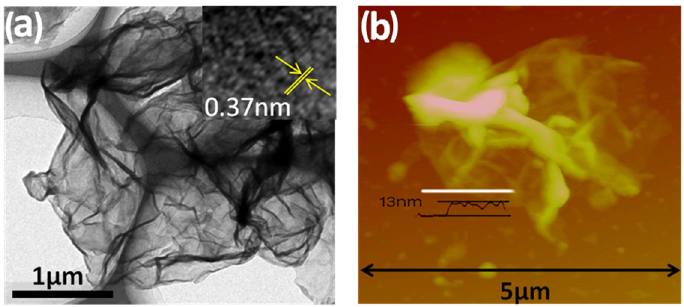
Figure 4. ( a ) TEM image; and ( b ) AFM image of G/S/C. Inset in ( a ) is the HRTEM image of